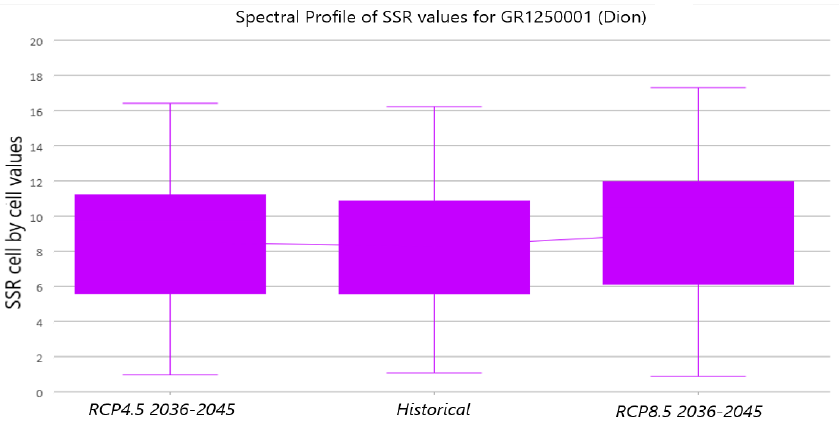
Figure 6. Spectral Profile of Seasonal Severity Rating (SSR) values for: GR1250001 (Dion), for RCP 4.5 2036–2045 ( left ), historic period ( centre ), and RCP 8.5 2036–2045 ( right ).